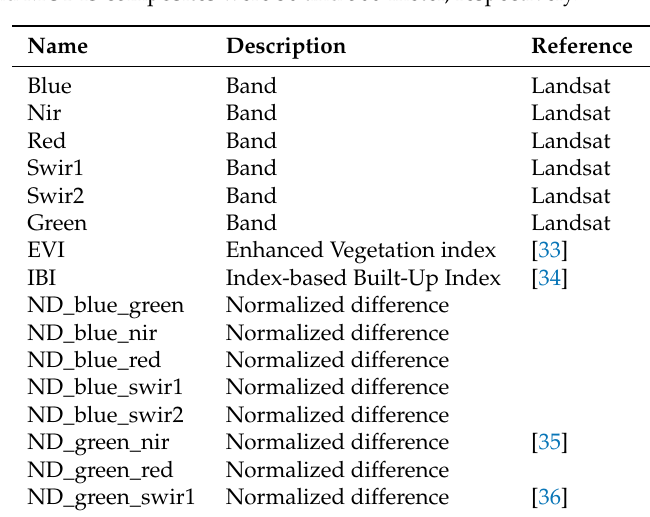
Table 2. Landsat and MODIS-derived data products and their covariates. Landsat bands and covariates were calculated for the medoid, 20th and 80th percentile of a yearly composite. MODIS bands and covariates were calculated for the periods Jan–Mar, Apr–Jun, Jul–Sep and Oct–Dec. Spatial resolution of the Landsat and MODIS composites were 30 and 500-meter,